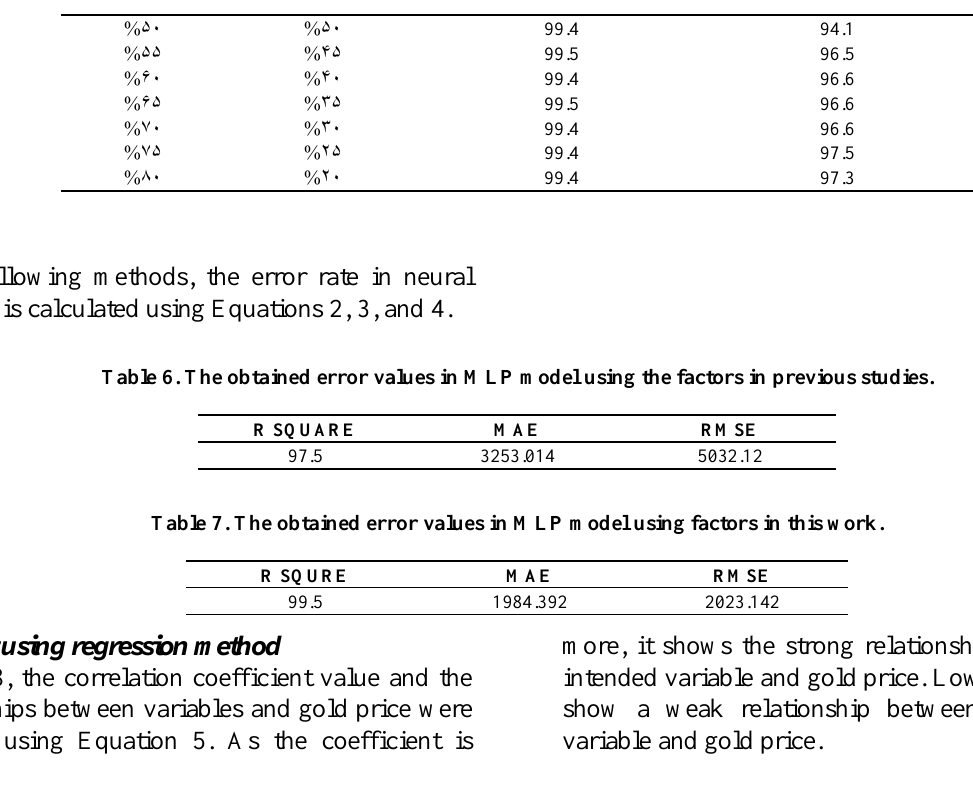
Table 8. The correlation coefficients related to the factors used in the